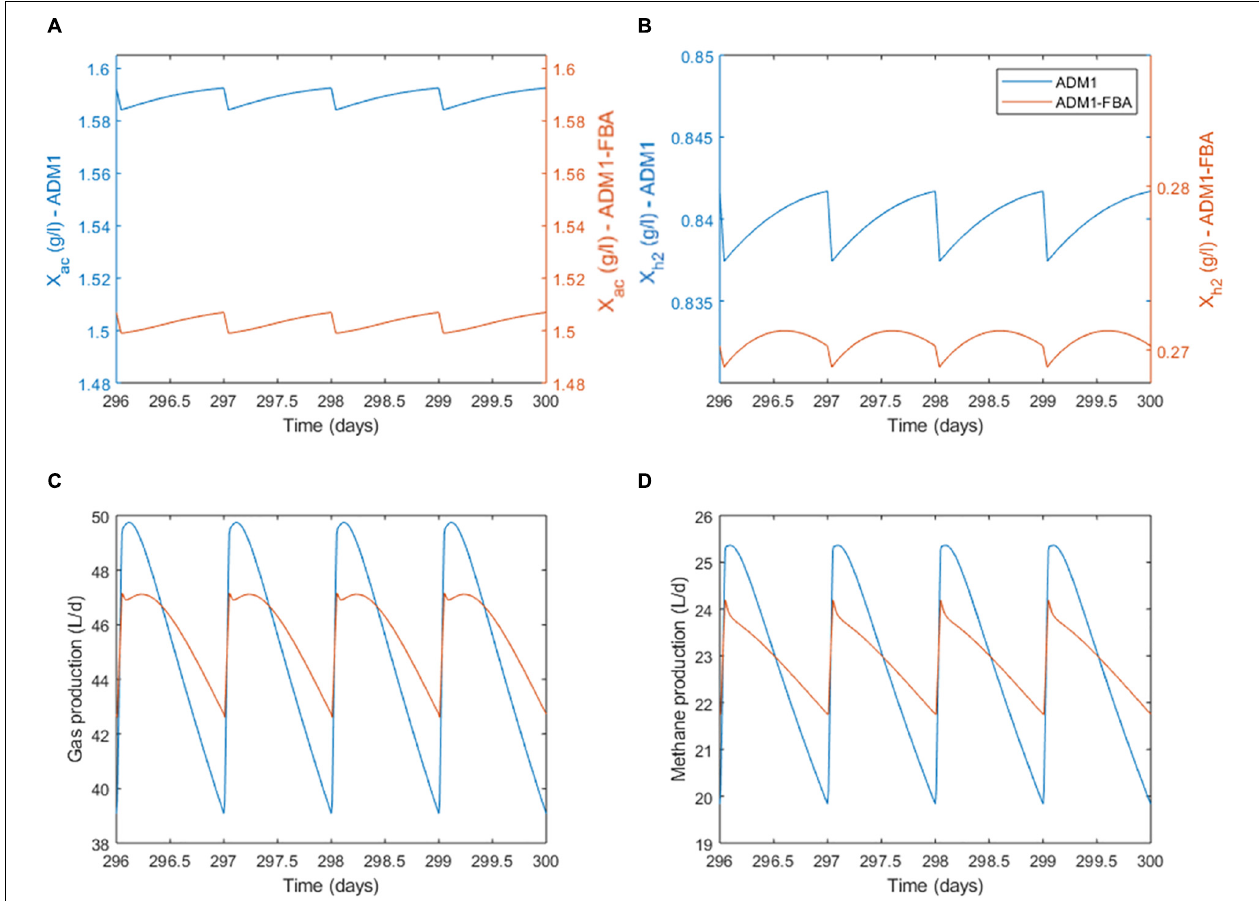
FIGURE 6 | Daily dynamics for the pulsed feeding regime. (A) Biomass concentration of the acetoclastic population. (B) Biomass concentration of the hydrogenotrophic population. Note the secondary y-axes scaling. (C) Process performance in terms of total gas production. (D) Process performance in terms of methane